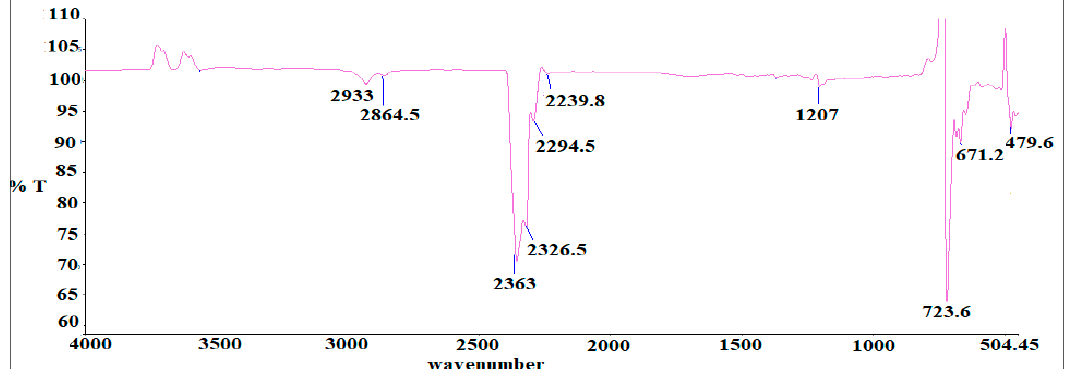
Figure 6. IR spectrum of as ‐ synthesized surfactant in hyphenated TG ‐ IR (curve 2).